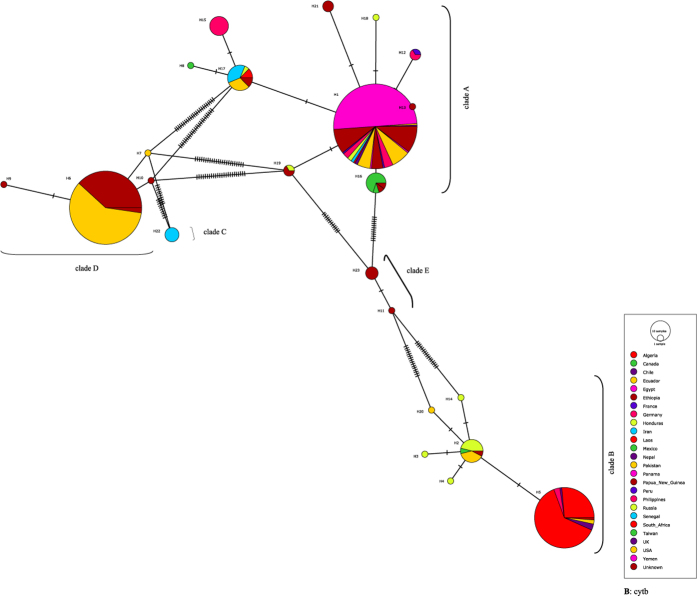
Cytb haplotype networks of head lice.Each circle indicates a unique haplotype and variation in circle size reflects the number of sequences assigned to a haplotypes. Pie colors and sizes in circles represent the countries and the number of their sequence records for a haplotype.